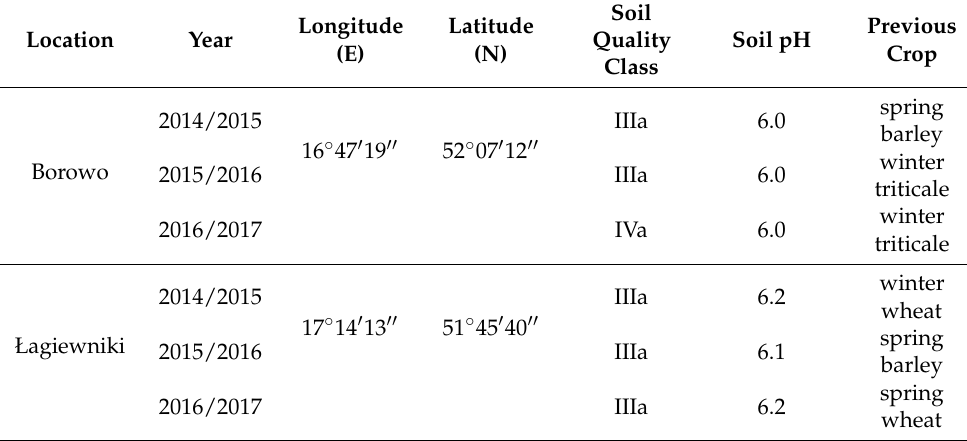
Table 2. Environments used in the study and their main